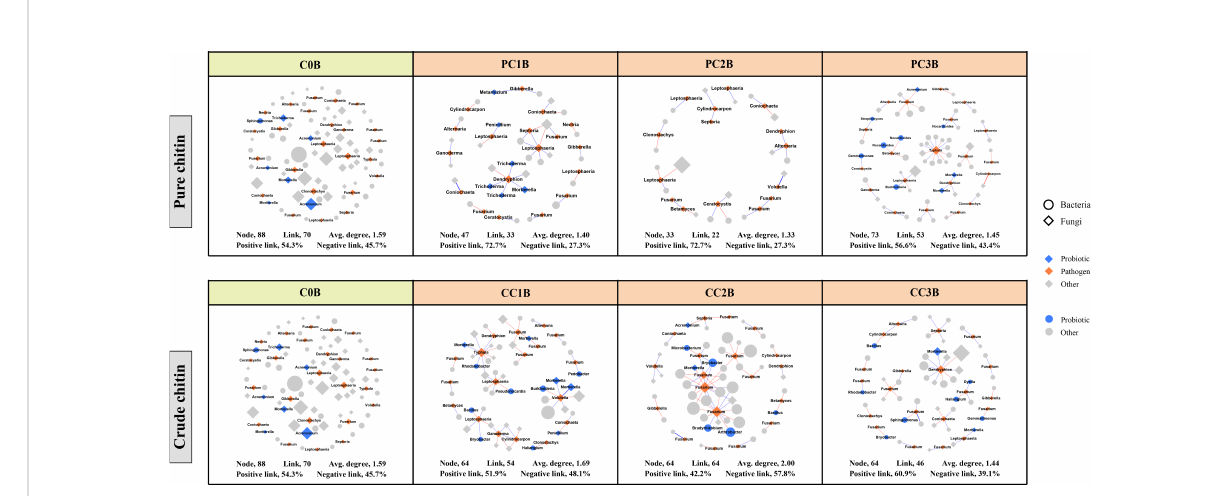
FIGURE 5 Subnetworks of potential plant pathogens separated from the microbial network under different pure and crude chitin addition dosages in the bulk (B) soils. Circles and diamonds represent bacteria and fungi, respectively. The size of each node is proportional to degree. Node with blue, orange and grey indicate probiotic, pathogen and other, respectively. The microbial taxa are labeled in the blue and orange nodes. Blue and red lines show positive and negative interactions between two individual nodes, respectively. The treatment description is same as Figure